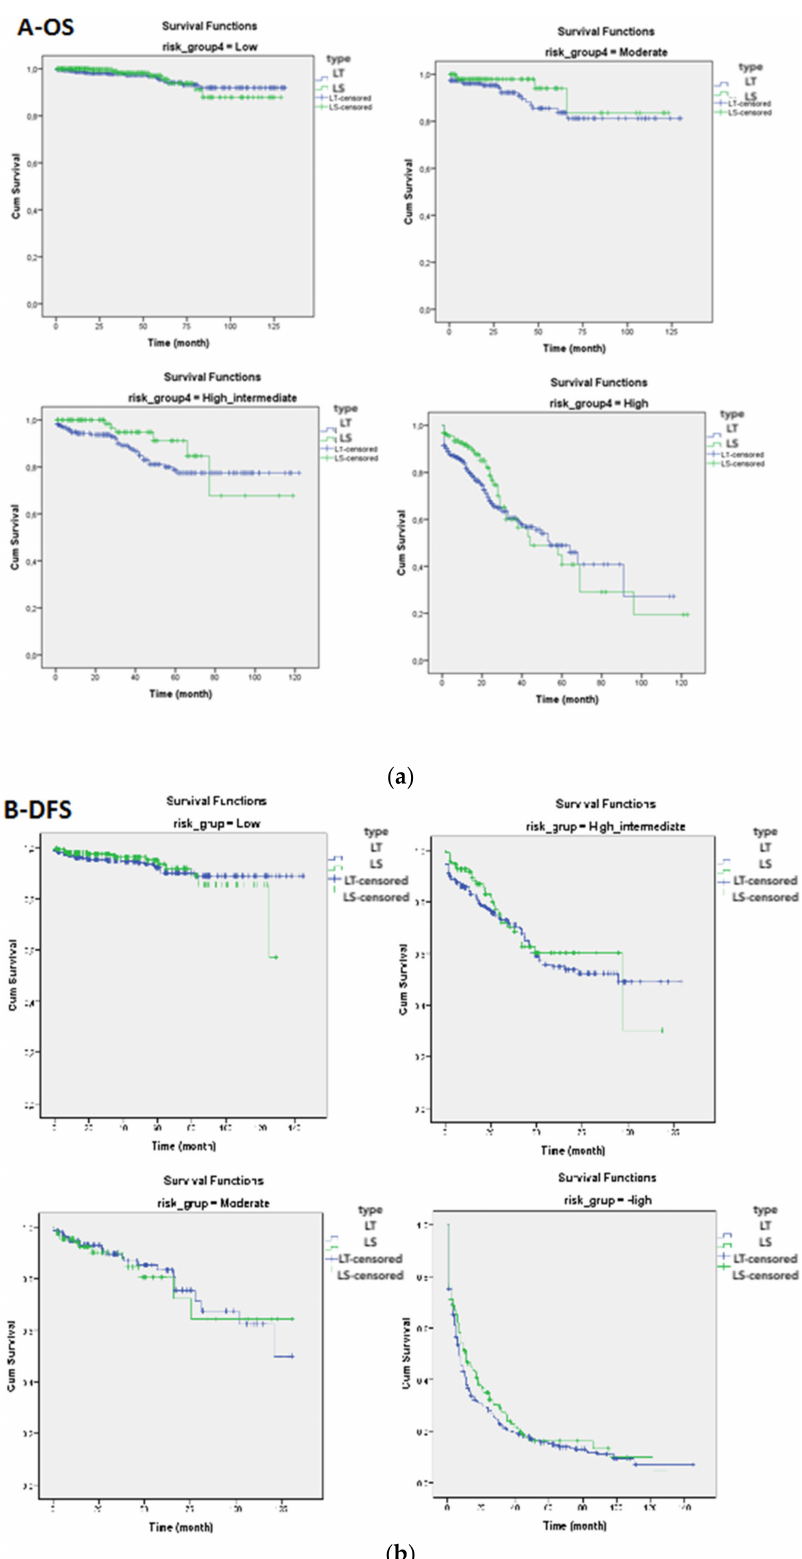
Figure 1. ( a ) Comparison of overall survival (OS) and ( b ) disease-free survival (DFS) curves between the laparotomy and laparoscopy groups according to the low-, moderate-, high–intermediate- and high-risk